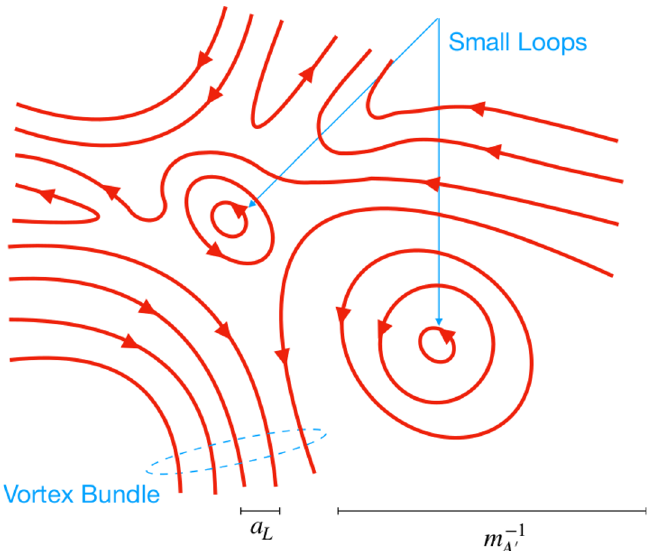
Figure 14 . A schematic view of the vortex network generated after a superheated phase transition, but before the melting phase transition is complete. The long vortex lines have length L & m − 1 A 0 and relatively uniform direction on scales of order m − 1 , forming a vortex bundle. The vortex line A 0 separation is of order a L , the lattice spacing. The long vortex bundle emits gravitational waves with frequency ω ∼ 1 /L , while the small string loops disappear quickly into high energy dark photon longitudinal modes with ω ∼ 1 /a L